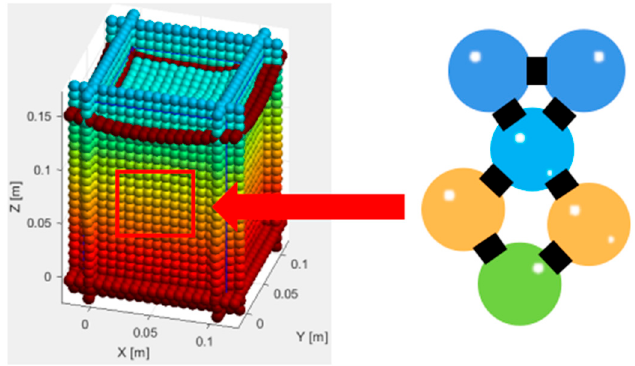
Figure 3. Uniaxial numerical model of sandstone specimen.